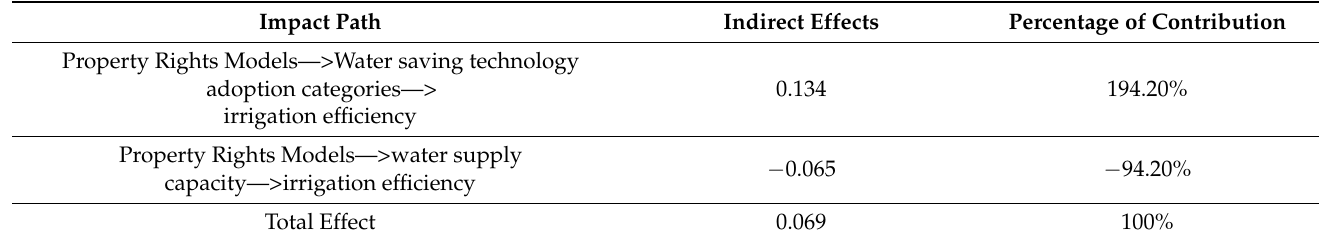
Table 13. Indirect and total effects of MCG-Model on irrigation efficiency